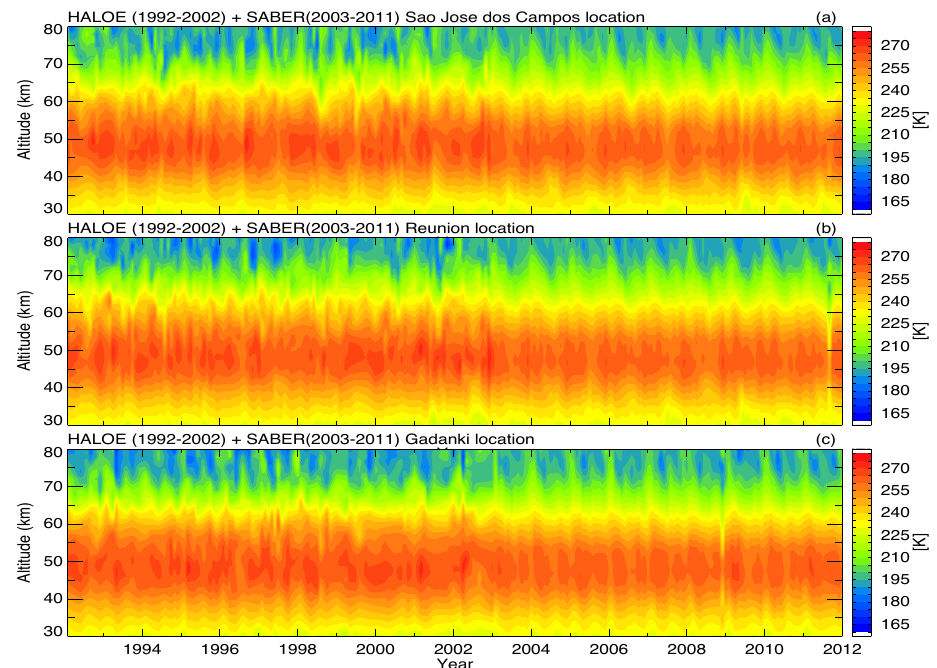
Fig. 4. Monthly mean temperature contours constructed using HALOE (1992–2002) and SABER (2003–2011) measurements over (a) São Figure 4: Monthly mean temperature contours constructed using HALOE (1992-2002) and SABER (2003-2011) measurements over José dos Campos, (b) Reunion, and (c) Gadanki (a) São José dos Campos, (b) Reunion, and (c) Gadanki locations.